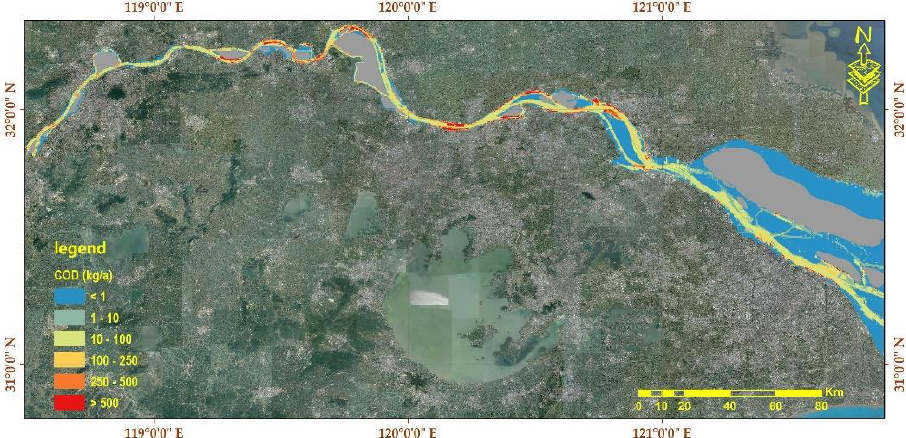
Figure 8. COD generations distribution.